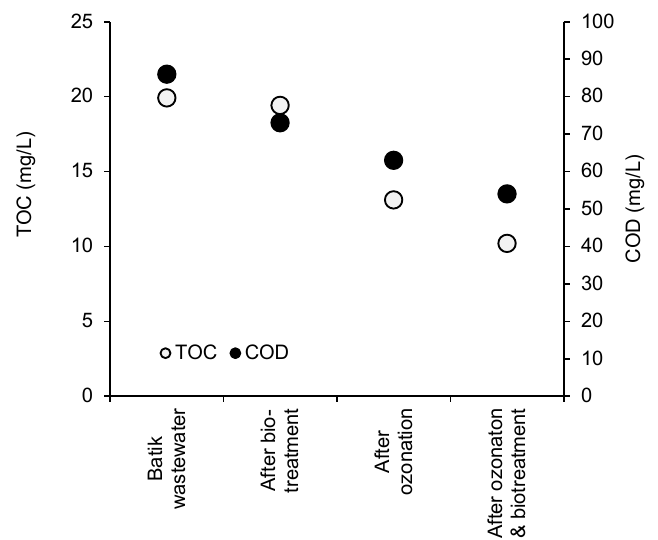
Figure 6. Decrease in TOC and COD concentrations in synthetic batik wastewater containing 48 mg/L RB5 and 48 mg/L RO16 after 14 days of biodegradation; 15 min ozonation; and 15 min ozonation followed by 14 days of